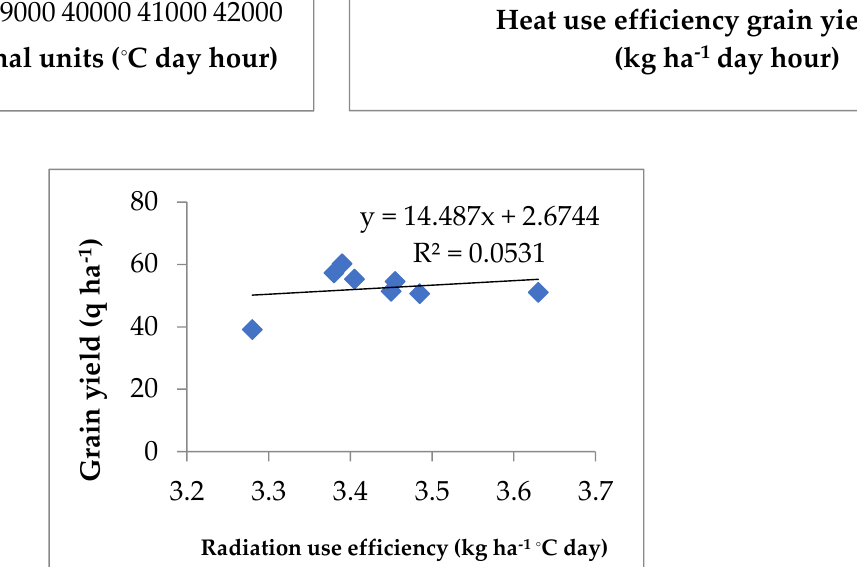
y = 0.0061x – 188.87